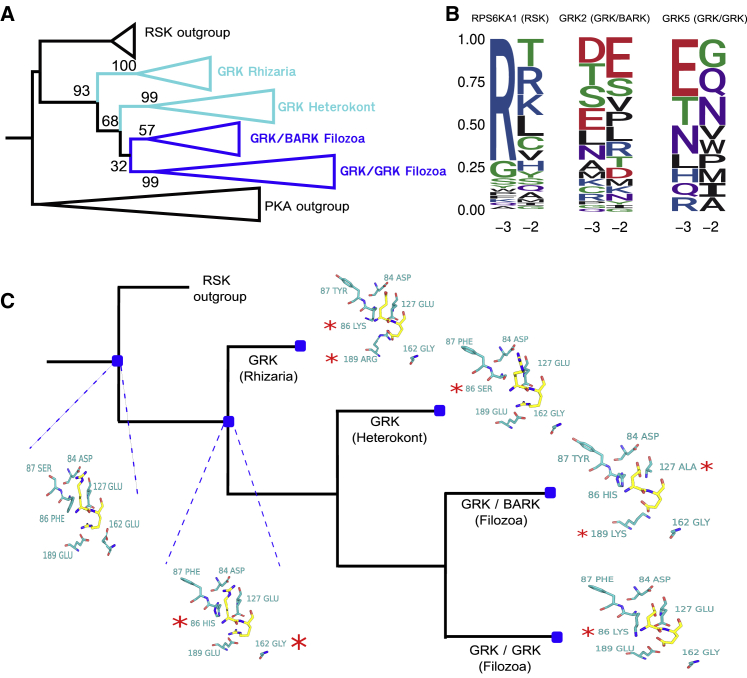
Evolution of GRK Family Specificity(A) Phylogeny of kinases in the GRK family, including an outgroup of RSK kinases in humans. The supporting number of bootstrap replicates (/100) for relevant clades and bifurcations is represented. The Filozoa represent animals and their closest unicellular relatives, while the Rhizaria and Heterokonts are distantly related protist groups.(B) Logos at positions −3 and −2 for human RSPS6KA1 (RSK kinase), human GRK2 (GRK/BARK kinase), and human GRK5 (GRK/GRK kinase). Sequence logos were generated from target phosphorylation sites.(C) Representation of substrate positions −2 and −3 (yellow) and their corresponding kinase binding pockets (cyan) for extant kinases and predicted ancestral sequences. Substitutions in the binding pocket are denoted by a red asterisk.